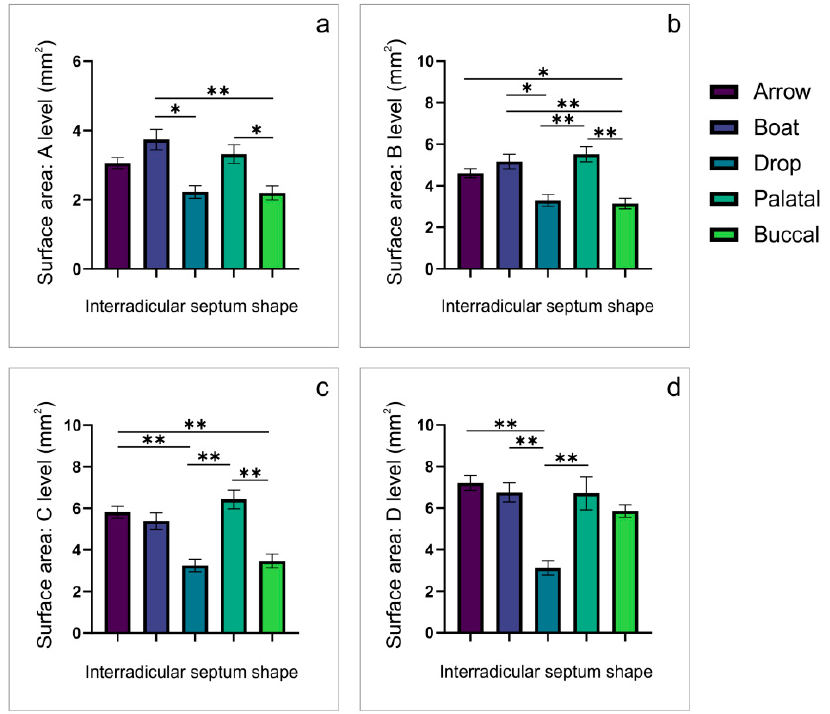
Figure 6. The observed differences in IRS surface area for the second maxillary molars obtained in the axial CBCT views. ( a )—at the A level; ( b )—at the B level; ( c )—at the C level; ( d )—at the D level. * Denotes a significant difference of p < 0.05, ** denotes a significant difference of p < 0.01.